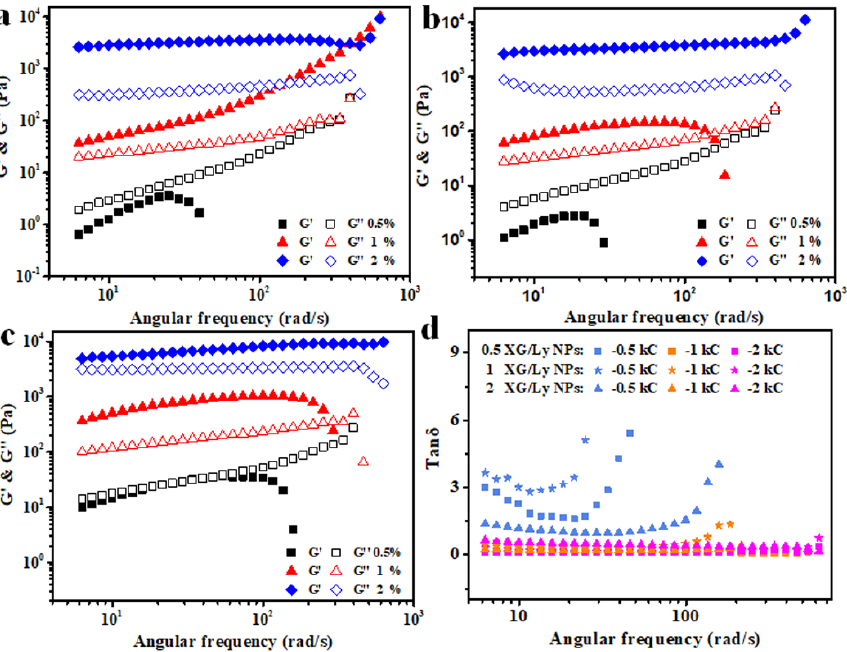
Figure 6. Frequency dependence of G′ and G″ for Pickering e mulsion gels prepared by different concentration of XG/Ly NPs ( a -0.5%, b -1%, c -2%) at various concentrations of kC as a function of angular frequency and the frequency dependence of tan δ ( d ) for emulsion gels.